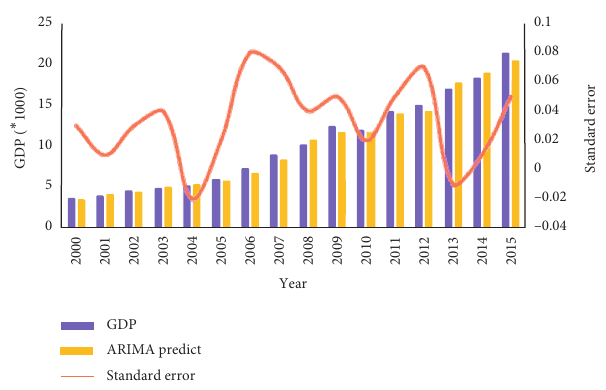
Figure 9: Comparison of model fitting